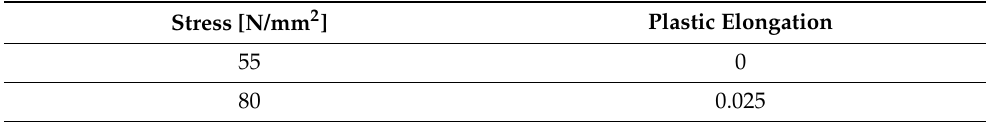
Table 2. Plasticity properties of aluminum 99.8 (H12) [DIN485-2].